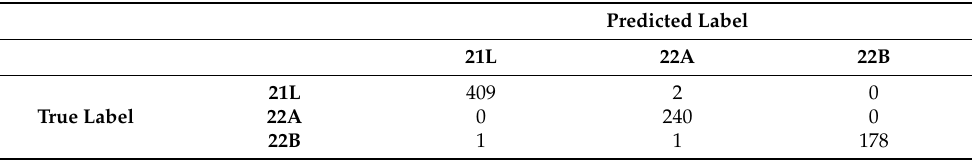
Table 6. Confusion matrix resulting from the test of the sub-model, comprising 831 samples belonging to 3 clades (21L, 22A, and